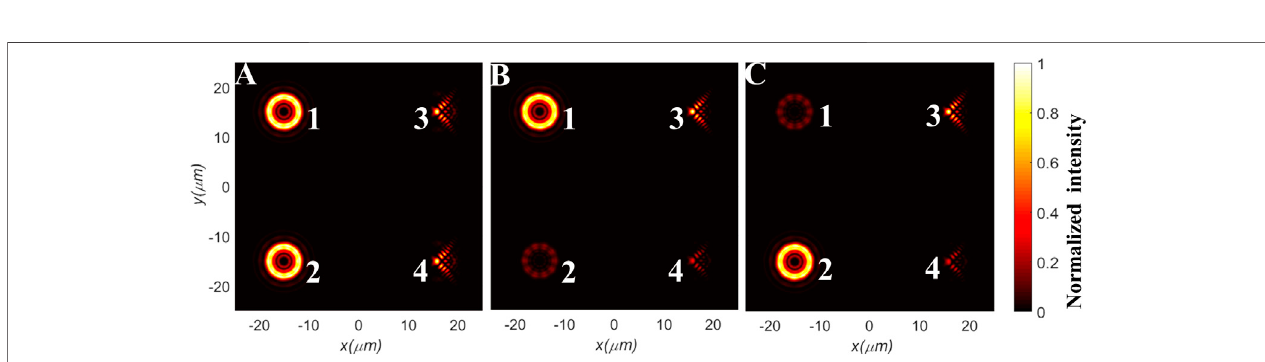
FIGURE8| Adjustingthepeakintensityofdifferentopticaltraps. (A) Thepeakintensitiesofthefouropticaltrapsareapproximatelyequal. α 1 , α 2 , α 3 ,and α 4 are2.6, 2.6, 1,and1,respectively. (B) Keepthepeak intensitiesofopticaltraps 1and 3,whilethepeak intensitiesofopticaltraps 2and 4arerelativelyweakened. α 1 , α 2 , α 3 ,and α 4 are2.6,1.3,1,and0.5,respectively. (C) Keepthepeakintensitiesofopticaltraps2and3,whilethepeakintensitiesofopticaltraps1and4arerelativelyweakened. α α α 2 , 3 , and 4 are 1.3, 2.6, 1, and 0.5,